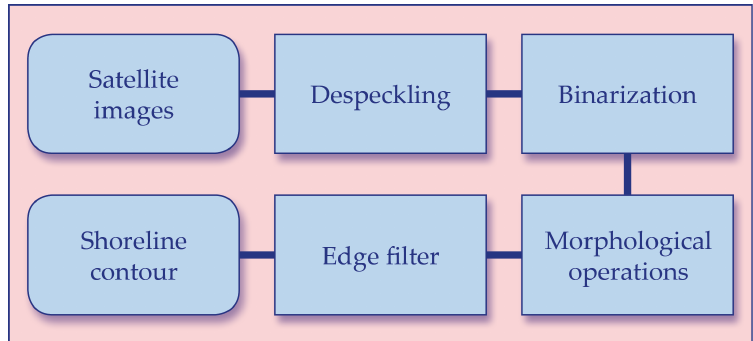
Figure 4. Block diagram of the processes composing the